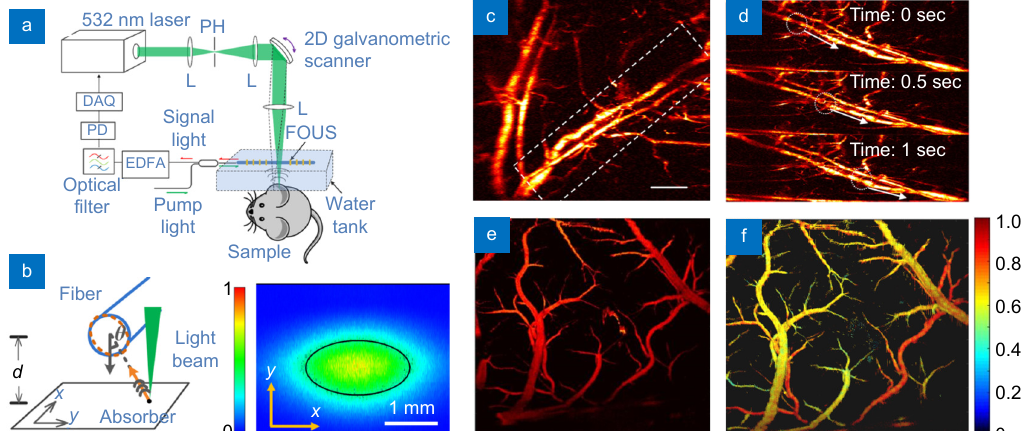
Fig. 5 | ( a ) Schematic of a fiber-based PAM apparatus. (b) Schematic (left) and result (right) of the field-of-view measurement. ( c ) PAM result of a mouse ear that contains branches of blood vessels and capillaries. ( d ) Three consecutive snapshots showing the blood flow in the mouse ear. ( e ) Hemoglobin concentration image of a mouse brain obtained with a 532 nm pulse laser. ( f ) Oxygen saturation images enabled by a dual- wavelength laser source 33,34